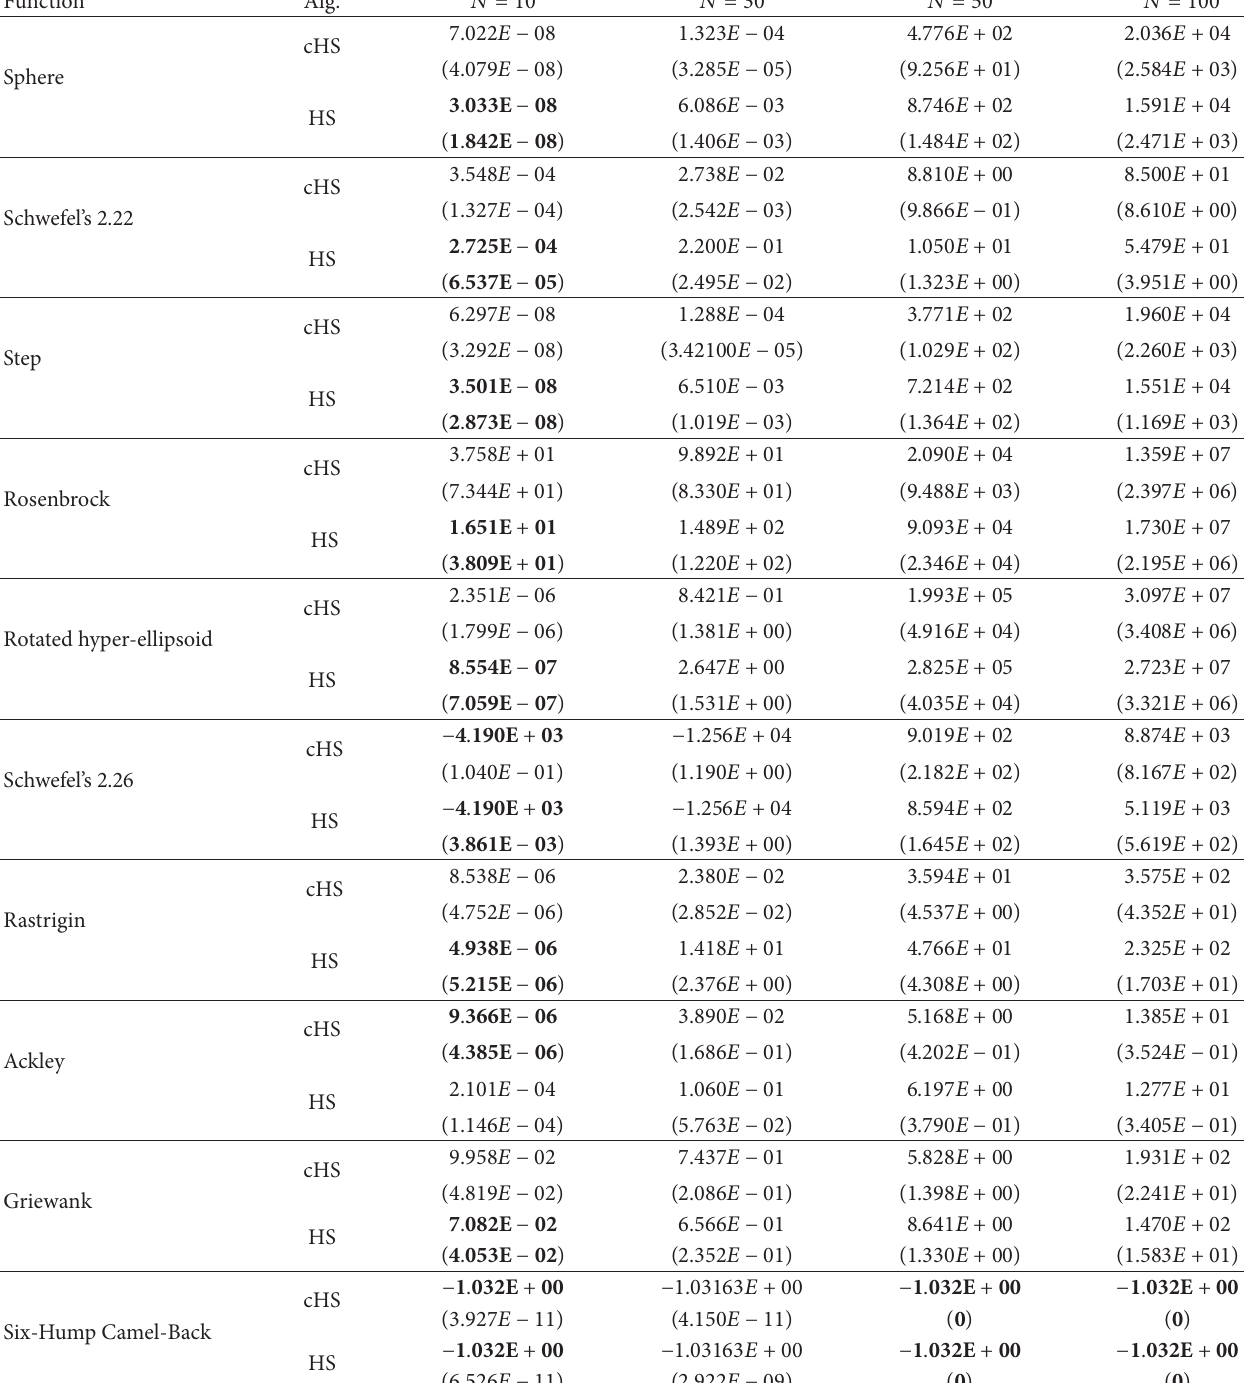
Table 8: Mean and standard deviation of ten functions ( 𝑓 1 – 𝑓 10 ) when 𝑁 = (10, 30, 50, 100)